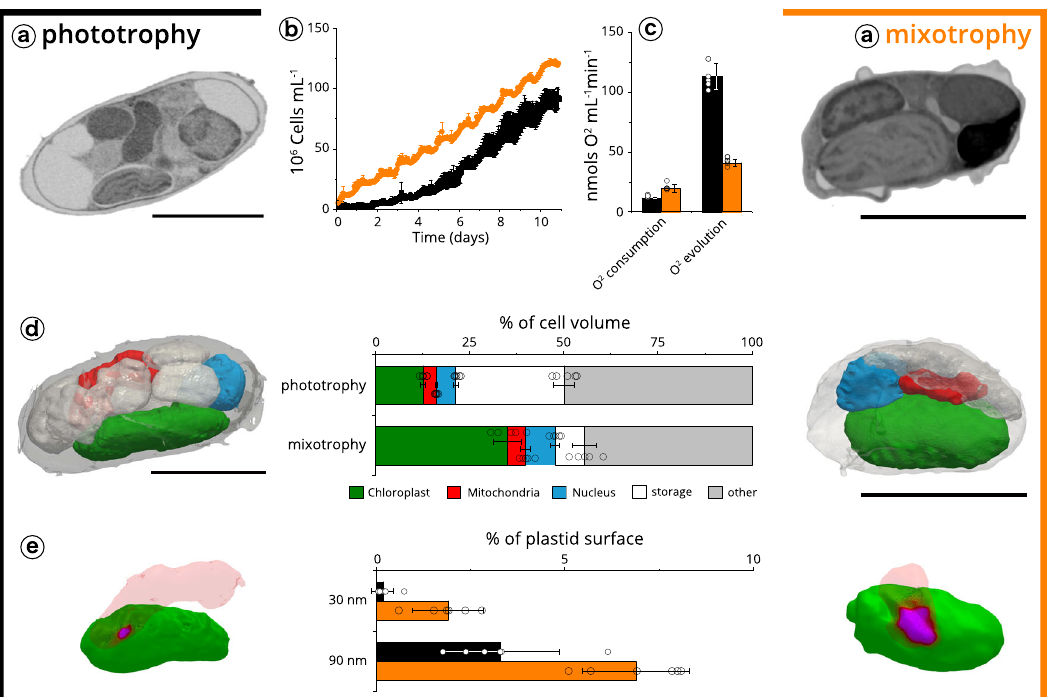
Fig. 7 Plastid-mitochondria interactions are modi fi ed by trophic regimes in Nannochloropsis . a Cells were imaged after growth in phototrophic (left) and mixotrophic (right) conditions. Sections are representatives micrographs of an experiment repeated three times with similar results. Scale bar: 2 µ m. b Cell growth in phototrophic conditions (black) and mixotrophic conditions (orange). Data refer to three biological samples ± s.d. for each growth condition. c Oxygen consumption (respiration) and evolution (photosynthesis). Data refer to six biological samples ± s.d. for each growth condition. d Cell-volume occupancy by the different subcellular compartments in different microalgal cells. Green: plastid; red: mitochondria; blue: nuclei; white: storage vesicles; grey: other. Data refer to fi ve cells ± s.d. for each growth condition. Scale bar: 2 µ m. e analysis of proximity surface points (magenta) between plastid (green) and mitochondria (red). Data refer to fi ve cells ± s.d. for each growth